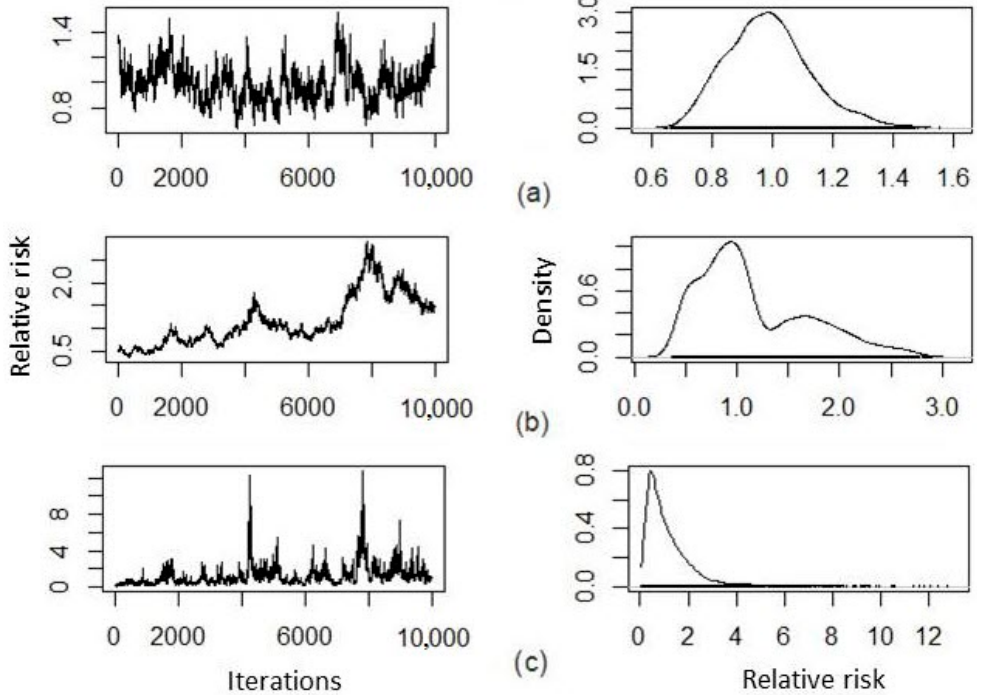
Figure 10. Posterior distribution of the selected parameters ( a ) EI, ( b ) Urban and ( c ) Forest; The left panels are trace-plots and the right panels contain density estimates.